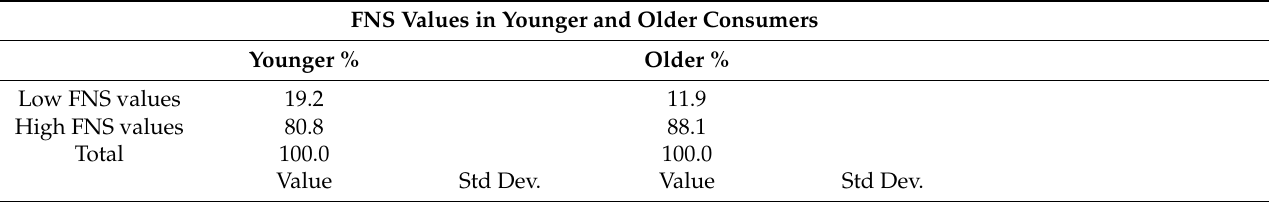
Table 4. Italian consumers’ food neophobia scale values and willingness to try yerba